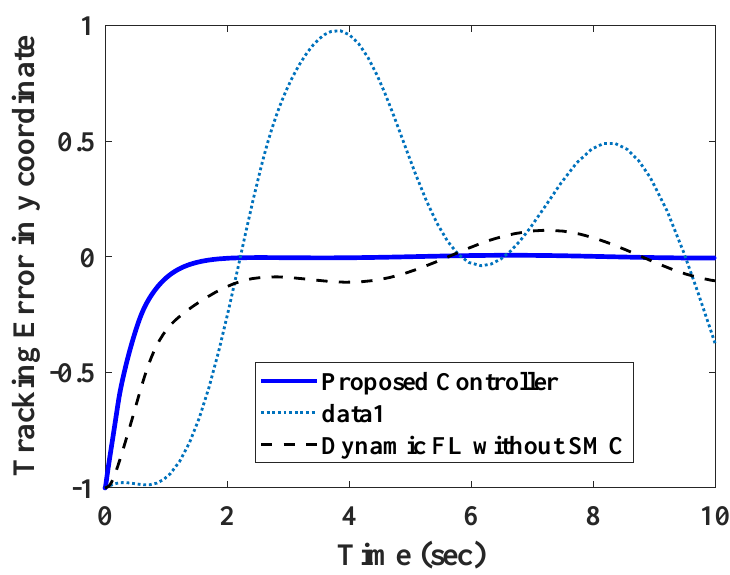
Figure 11. Comparison of Position Error in y